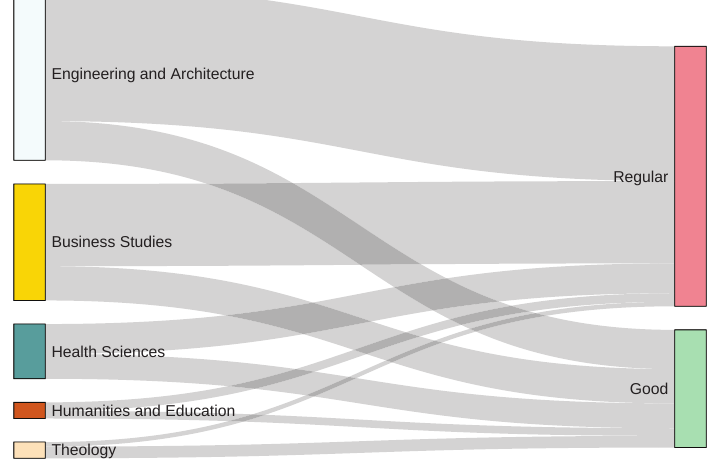
Figure 6. Student’s Performance Classification distributed over faculty.